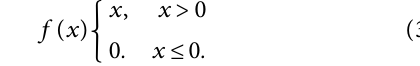
Figure 4: The first 4 stages of convolution operation.